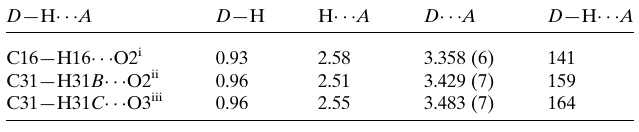
Table 2 Hydrogen-bond geometry (A˚ , (cid:4) ) for